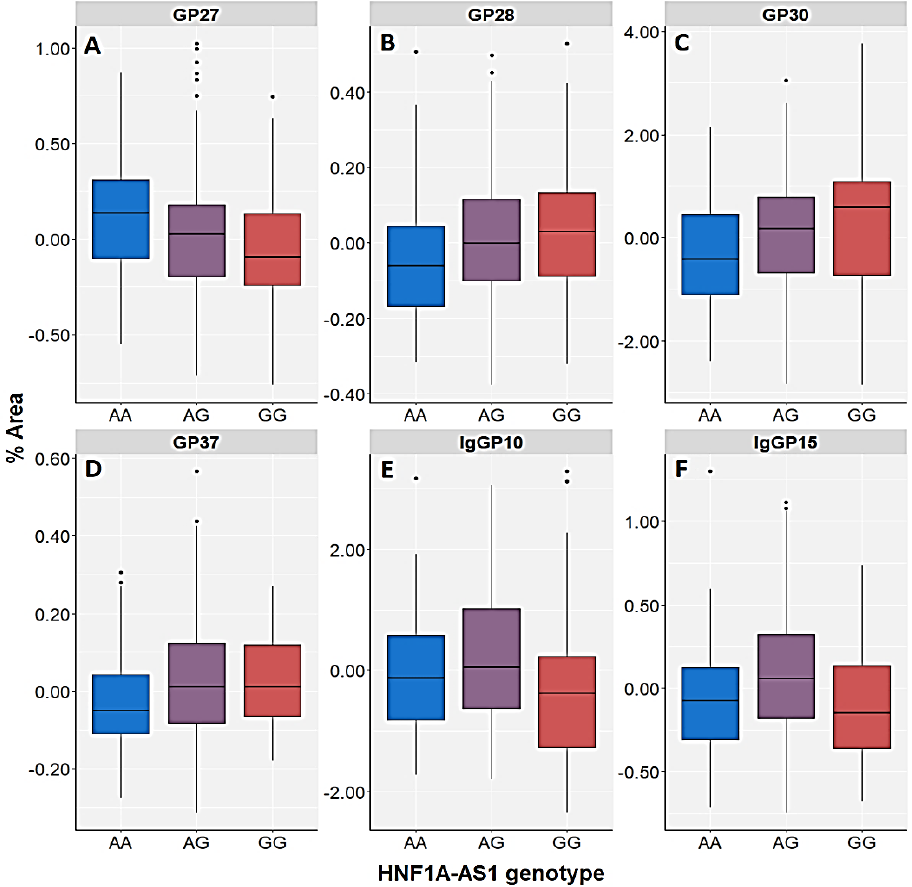
Figure 4. Relative distribution of the plasma N-glycan peaks (GP27 (A3G3S3) ( A ), GP28 (A3G3S3) ( B ), GP30 (A3G3S3) ( C ) and GP37 (A4G4S4) ( D )), as well as the IgG N-glycan peaks (IgGP10 (FA2[6]BG1) ( E ) and IgGP15 (FA2BG2) ( F )) in patients with PTSD subdivided according to different genotypes of the HNF1A-AS1 rs7953249 polymorphism. The central box represents the interquartile range of the age-adjusted percentage of the total N-glycan peak area, the middle line represents the median, the vertical line extends from the minimum to the maximum value and separate dots represent outliers.